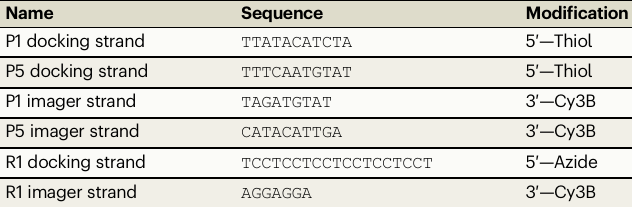
Table 1 | Sequences of docking and imager strands